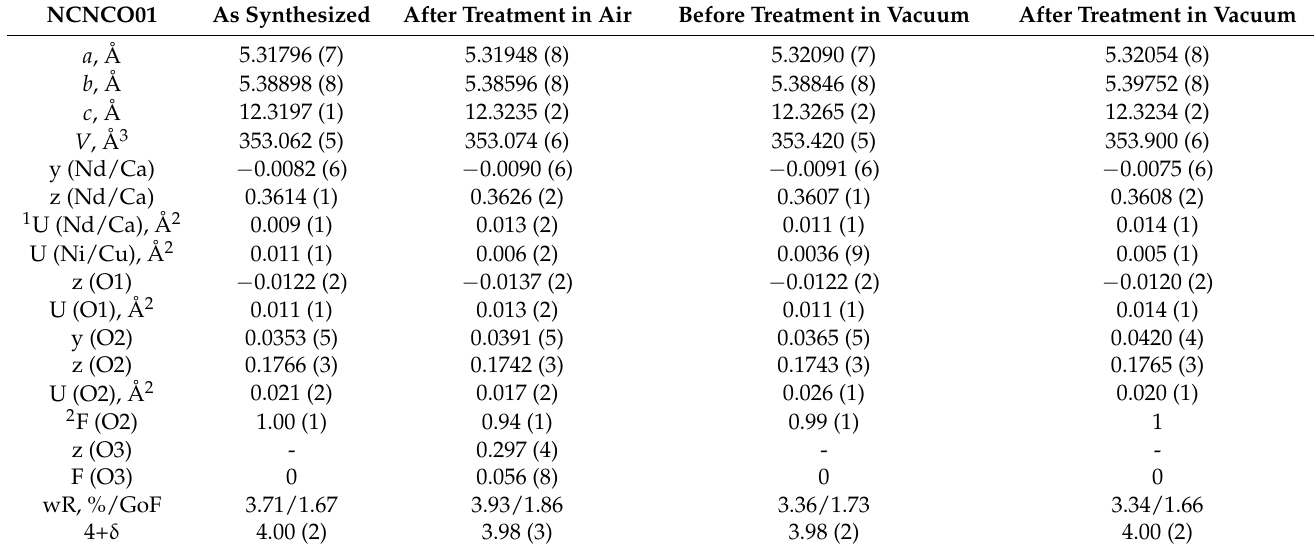
Table 1. Results of the Rietveld refinement of the NCNCO01 structure obtained at 50 ◦ C by TOF